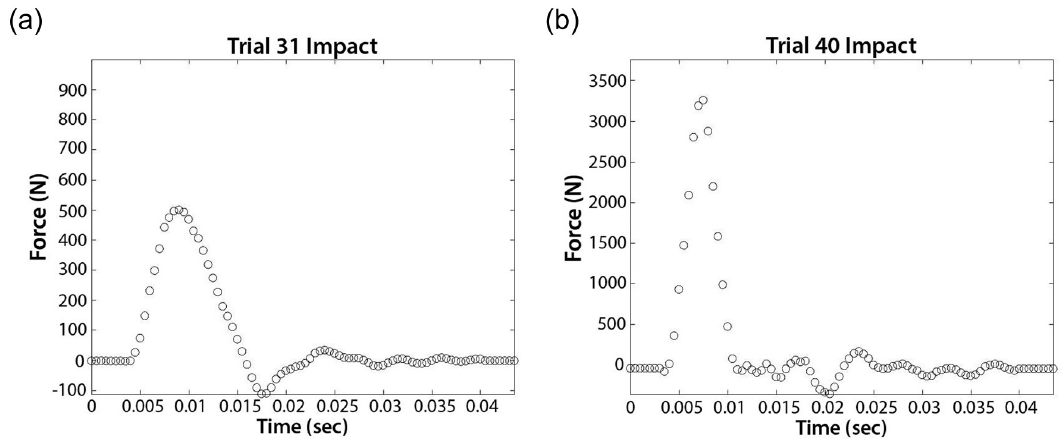
Fig 2. Two sample impact force waves. The first was taken from a size 4 soccer ball inflated to a pressure of 27.6 kPa and delivered at a speed of 4.57 m/s. The second was taken from a size 5 ball inflated to a pressure of 34.5 kPa and delivered at a speed of 14.6 m/s.